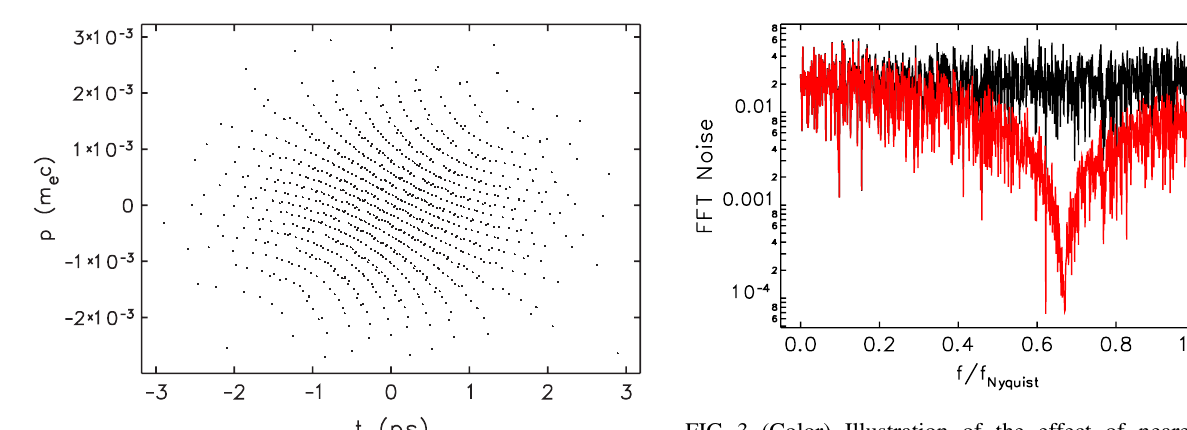
FIG. 3. (Color) Illustration of the effect of nearest-neighbor smoothing in the frequency domain.